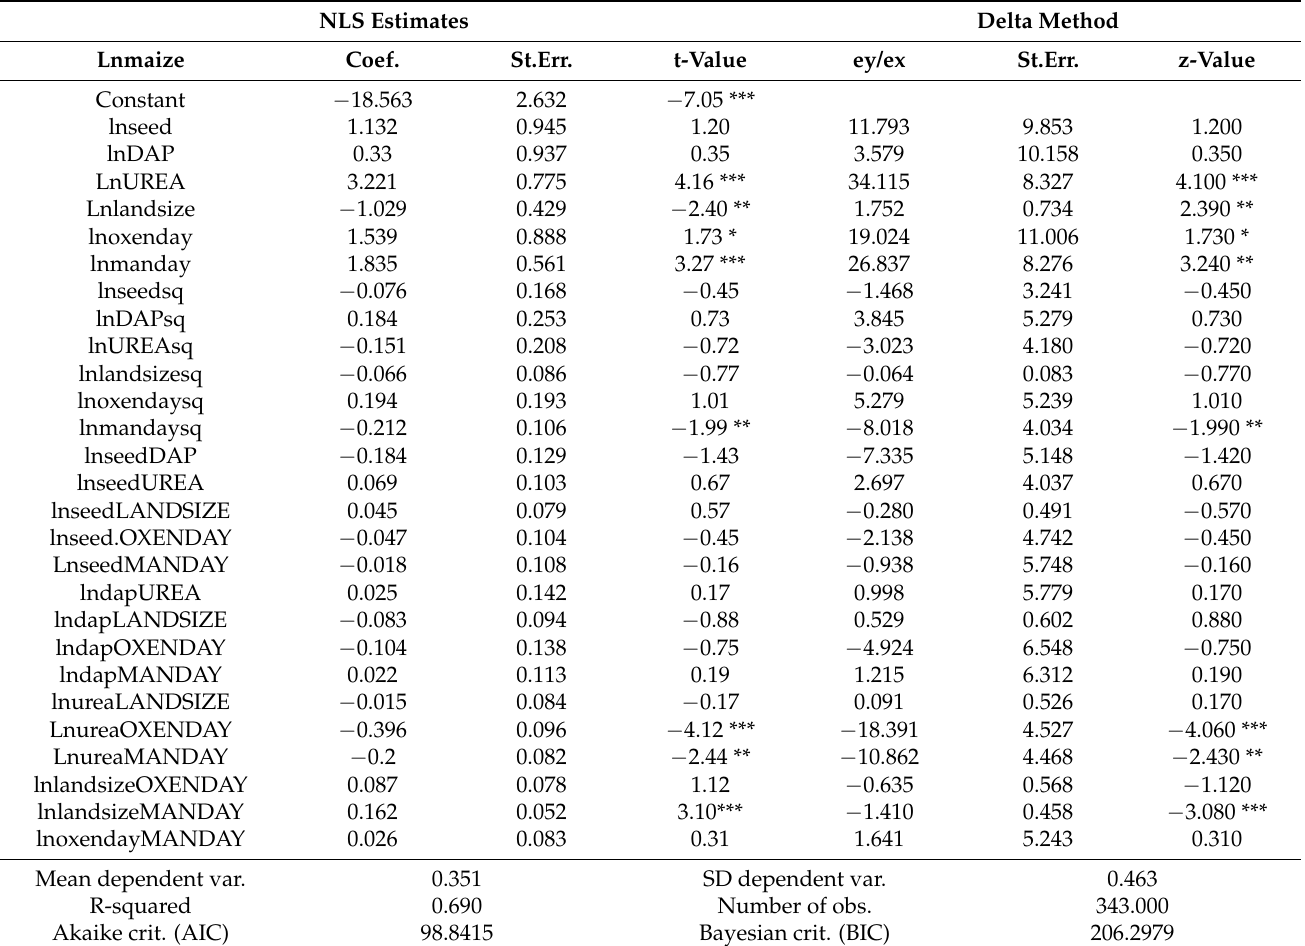
Table 2. NLS estimate of the translog